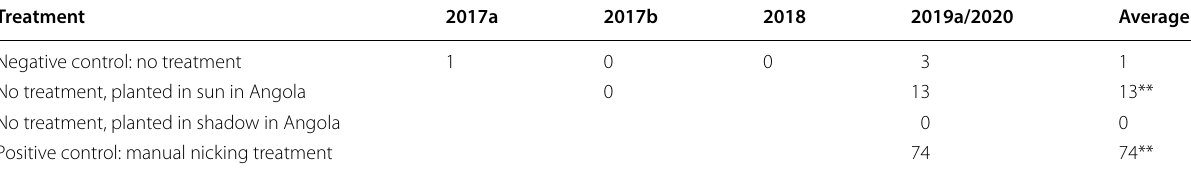
Table 1 Control test setups: Relative germination rate of Adansonia digitata seeds after 10 weeks [%]